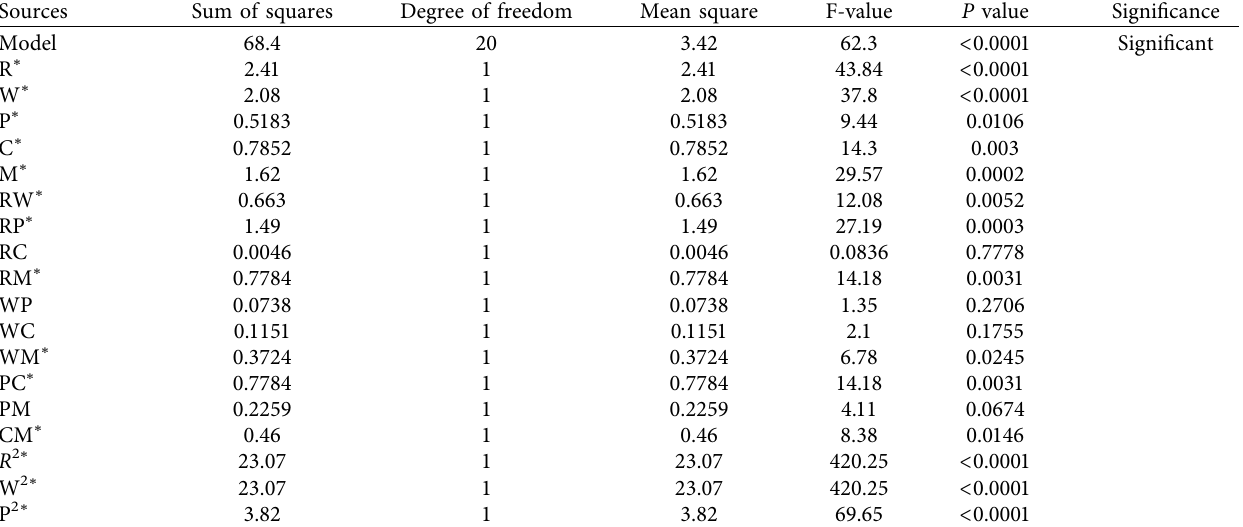
Table 10: ANOVA test results for corrosion